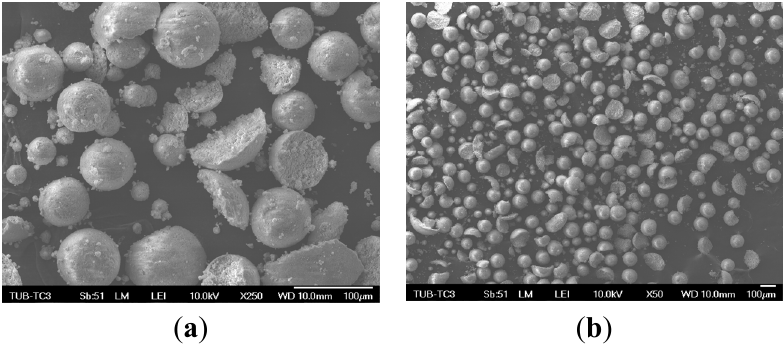
Figure 1. SEM image of broken hydroxyapatite granule-blends with 250× ( a ) and 50× ( b )